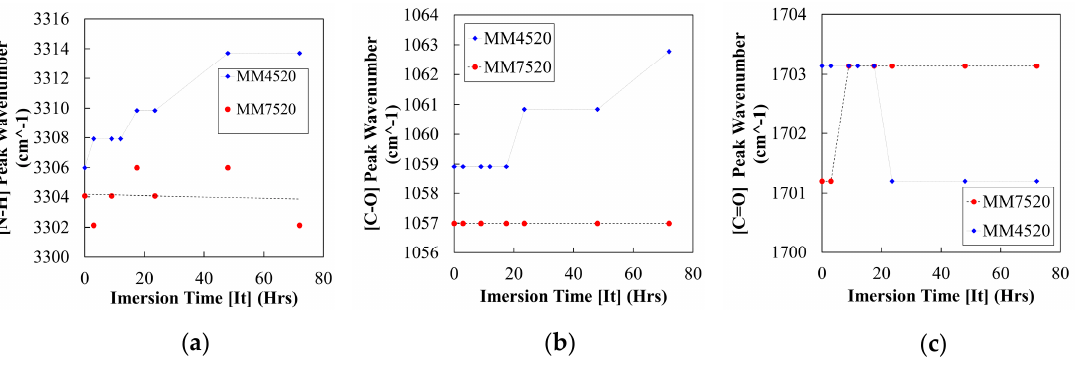
Figure 7. Values of bond stretching for ( a ) N–H bond, ( b ) C=O and ( c ) C–O bonds.